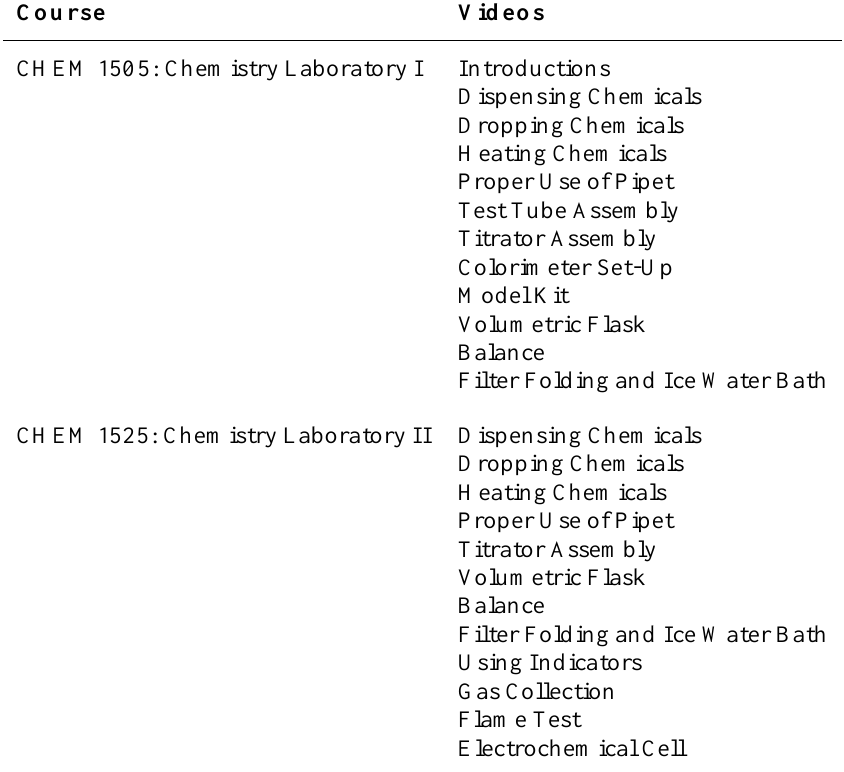
List of Instructional Videos Developed for the New Laboratory Courses